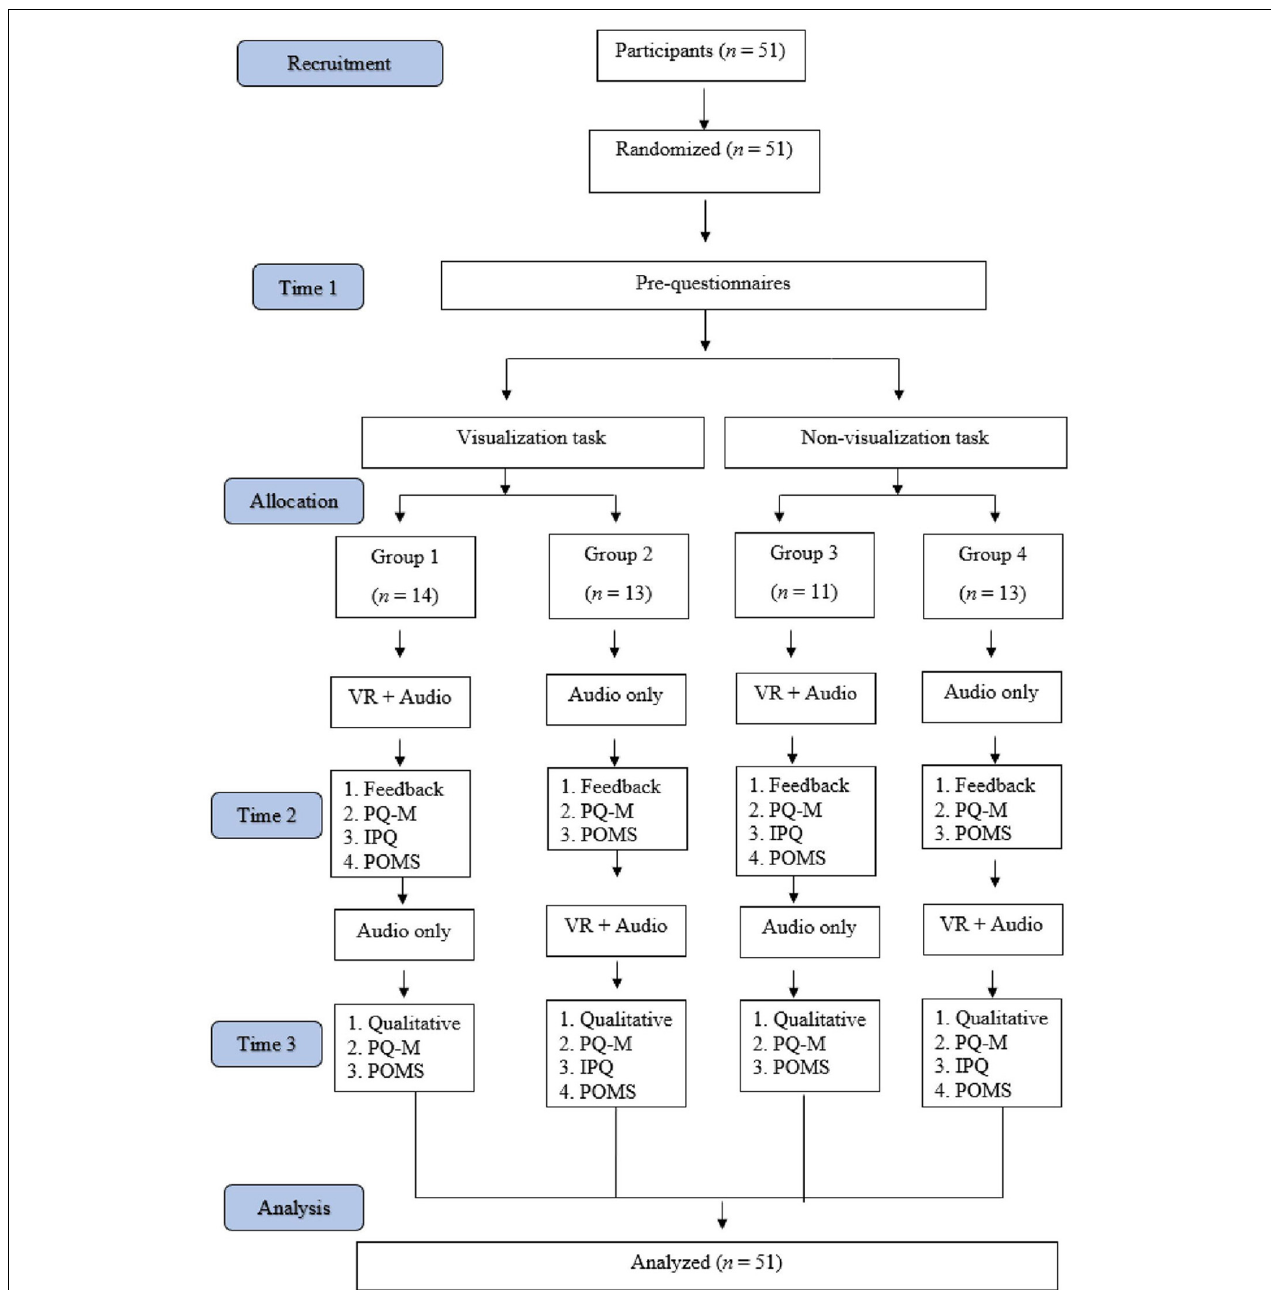
FIGURE 1 | Study consort diagram.